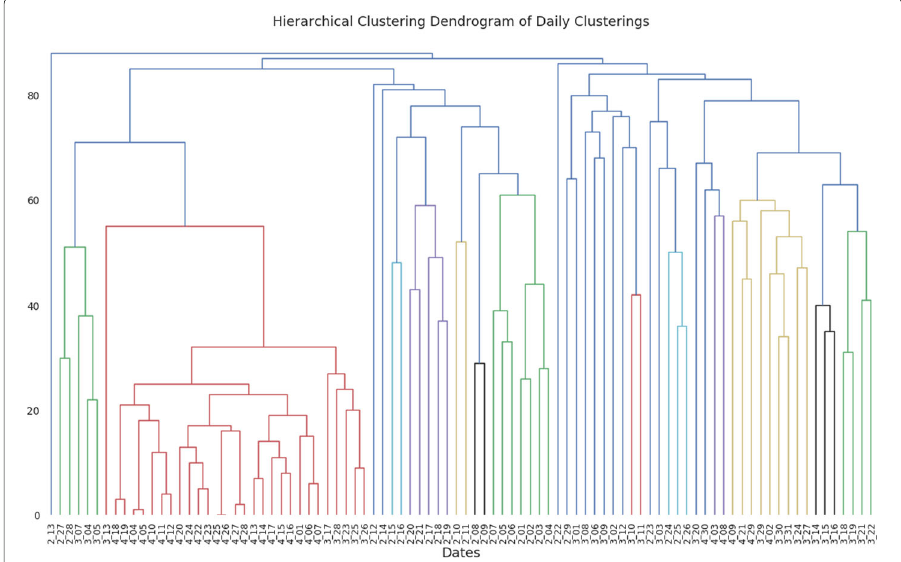
Fig. 6 Cluster Dendrogram of the daily clusterings produced by Agglomerative Hierarchical Clustering with ARI as the measure of similarity. The Dendrogram shows 3 main clusters with some outlier daily